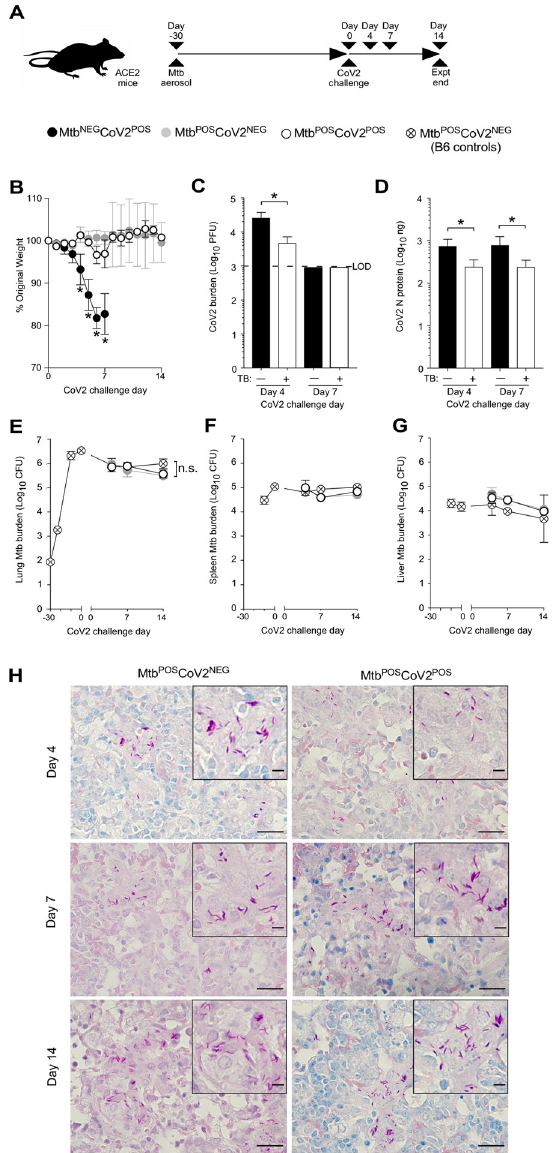
Fig 1. Mtb-infected ACE2 mice are resistant to secondary infection with CoV2. ( A ) Experimental overview of our ACE2:CoV2 model studies, wherein mice were infected via aerosol with Mtb (Day -30) and challenged 30 days later (Day 0) with CoV2. On post-challenge Day 4, Day 7 and Day 14, tissues were collected for microbiological and immunological assessments. Experimental groups included ACE2 mice which were not infected with Mtb prior to CoV2 challenge (Mtb NEG CoV2 POS ), ACE2 mice which were infected with Mtb but challenged with sterile saline (Mtb POS CoV2 NEG ), ACE2 mice which were infected with Mtb prior to CoV2 challenge (Mtb POS CoV2 POS ), and B6 controls which were infected with Mtb (to determine what if any impact human ACE2 transgene expression alone has on Mtb burdens). ( B ) The percent weight change experienced by each group of ACE2 mice following CoV2 challenge, as normalized to the original weight of each mouse. ( C ) CoV2 PFU burdens and ( D ) CoV2 N protein levels in the lungs of Mtb NEG CoV2 POS and Mtb NEG CoV2 POS mice. ( E-G ) Mtb CFU burdens in the ( E ) lungs, ( F ) spleen and ( G ) liver of Mtb POS CoV2 NEG and Mtb POS CoV2 POS mice, as well as B6 controls throughout the experiment time course. In each graph the following legend applies: Mtb NEG CoV2 POS , black circles or bars; Mtb POS CoV2 NEG , gray circles; Mtb POS CoV2 POS , white circles or bars. ( H ) Representative micrographs of AFB stained lung sections, as collected from Mtb POS CoV2 NEG and Mtb POS CoV2 POS mice at the indicated times post-challenge. In each micrograph, the large scale bar is 20 μ M and inset scale bar is 5 μ m. This experiment was repeated twice, each with similar results (4 mice/group/ timepoint). � , p � 0.05 as determined by either Student’s t-test or ANOVA; n.s., not significant.